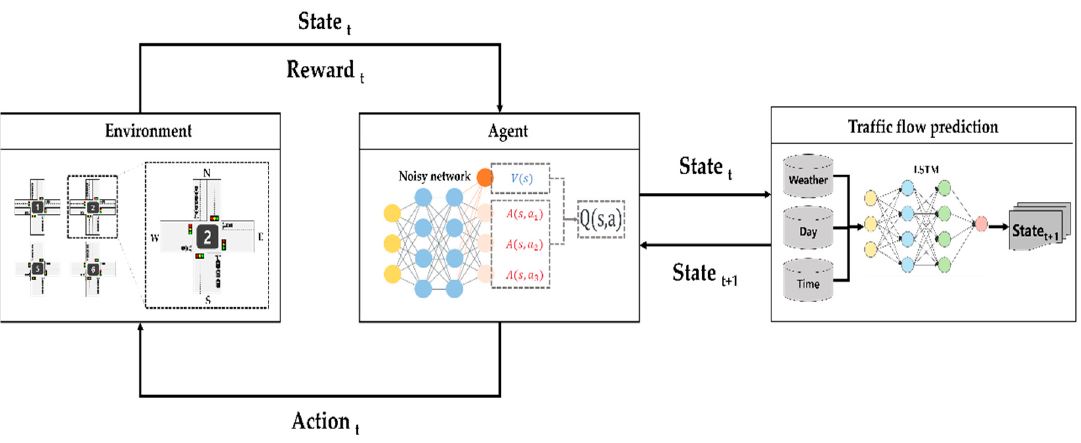
Figure 3. Overall architecture of TFP-CTSC. Figure 3 . Overall architecture of TFP-CTSC.